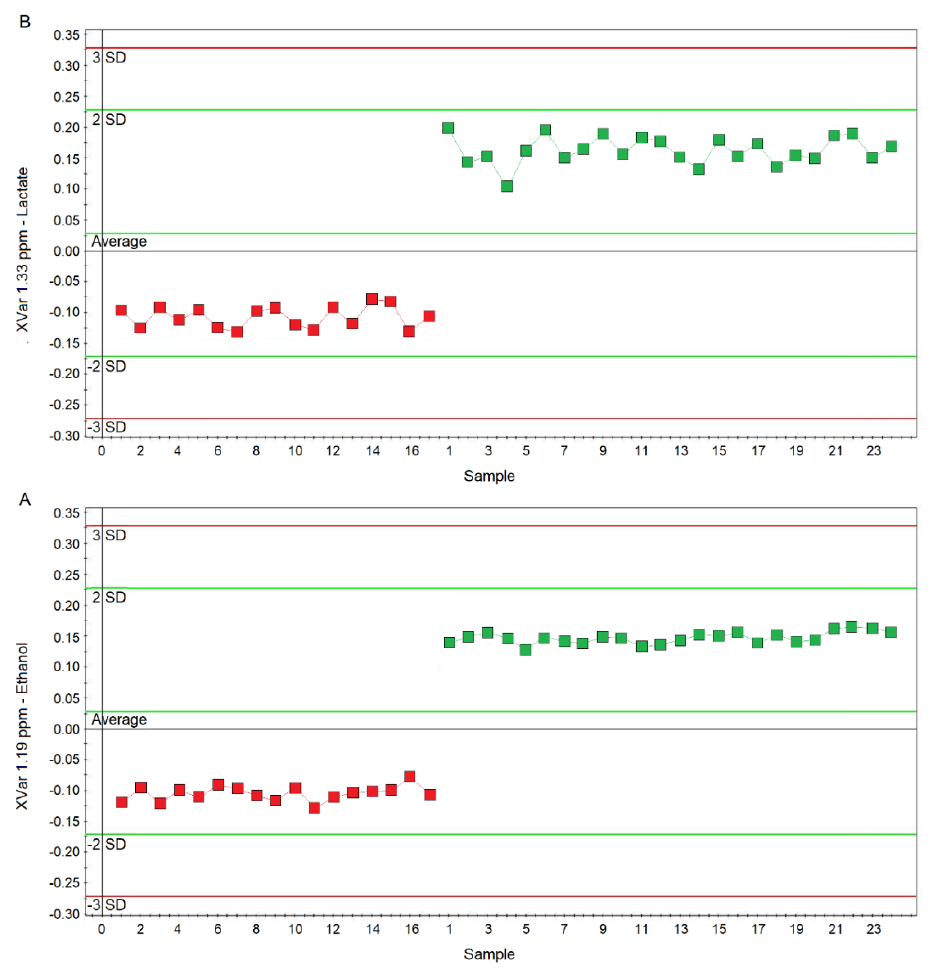
Figure 8. Plots of the NMR variables values for two of the four statistically significant metabolites contributing to the separation of the nPCD and nCF / nPCD classes. ( A ) Ethanol (XVar 1.19 ppm), ( B ) Lactate (XVar 1.33 ppm). Selected bucket variations are scaled to the total spectral area. nCF / nPCD patients are identified by red squares, while green squares identify PCD patients. Numbers on the x-axis refer to EBC samples used for the analysis; the y-axis reports the bucket variation. In PCD, the levels of ethanol and lactate are increased by 25% and 28%, respectively, with respect to nFC / nPCD (see text).